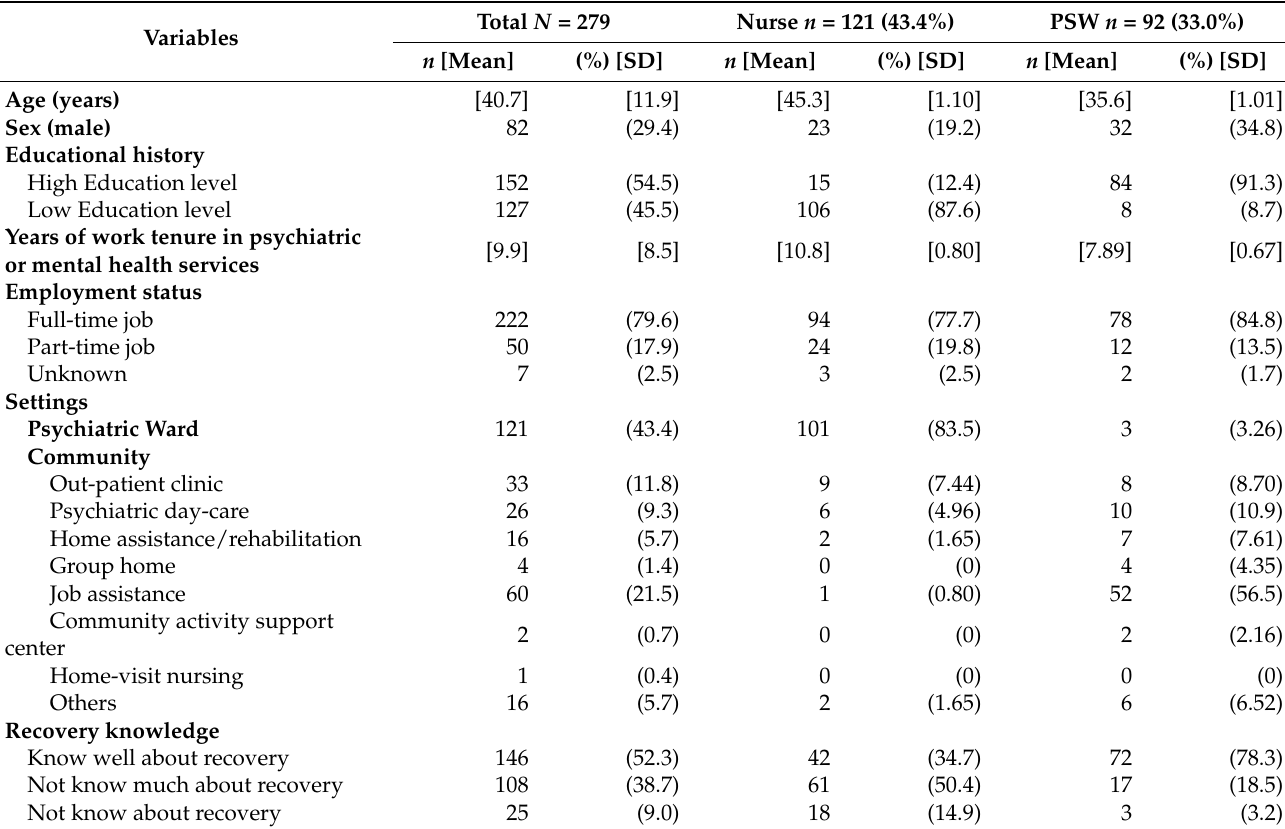
Table 1. Participants’ occupational and demographic characteristics for total samples, nurses, and psychiatric social